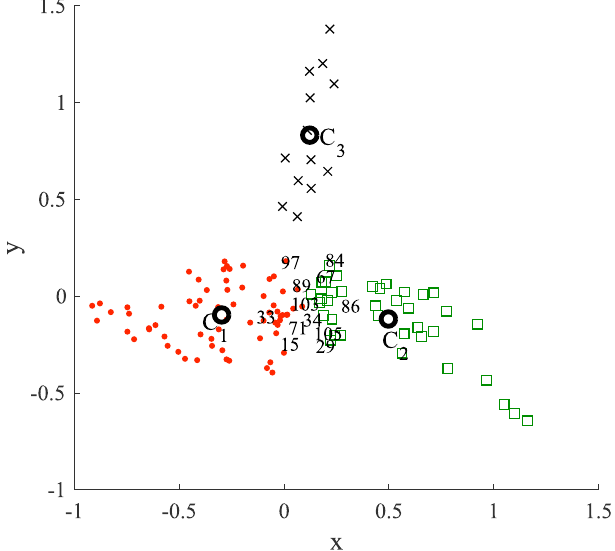
FIG. 13. K -means graph of the 3-cluster partition of our data. The numerically labeled points represent 12 students that in the 4-cluster H -CLA configuration 4A are placed into clusters α , β , and δ ∪ ε . The x and y axes simply report the values needed to place the points according to their mutual